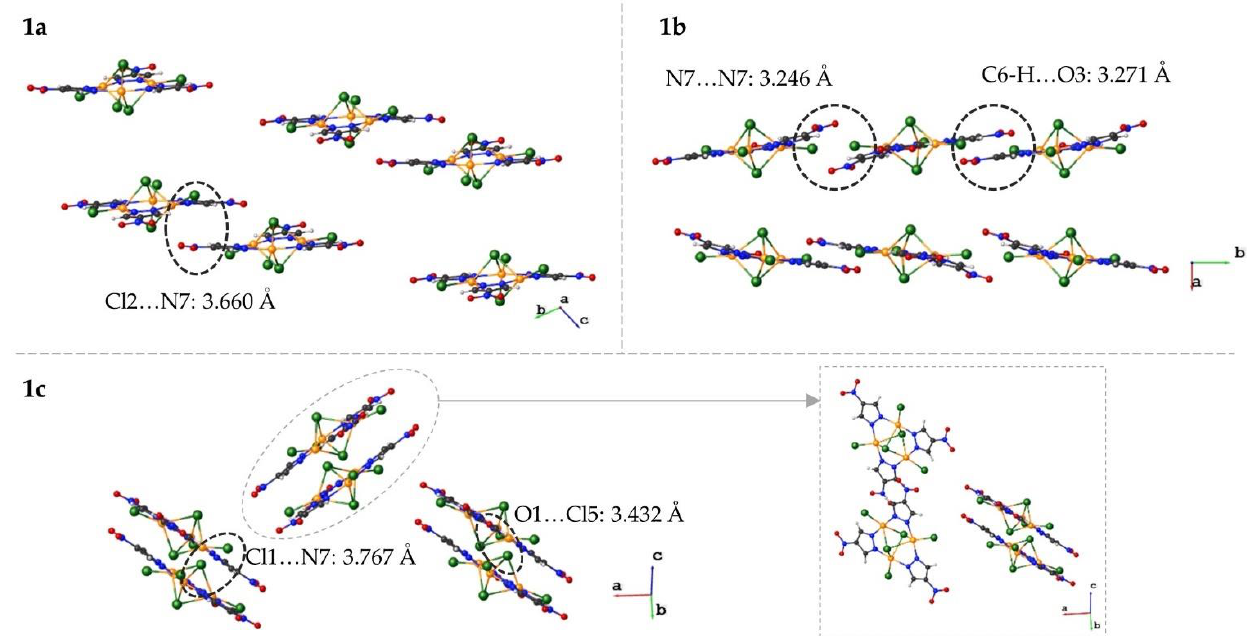
Figure 3. Crystal packing of the dianionic complex viewed approximately parallel to the Cu 3 plane for 1a (top left), 1b (top right), and 1c (bottom). The inset of 1c shows the rotation of the pair directly behind and in front of the specified pair. Significant interactions are circled and labeled with the identity and distance of the interaction.